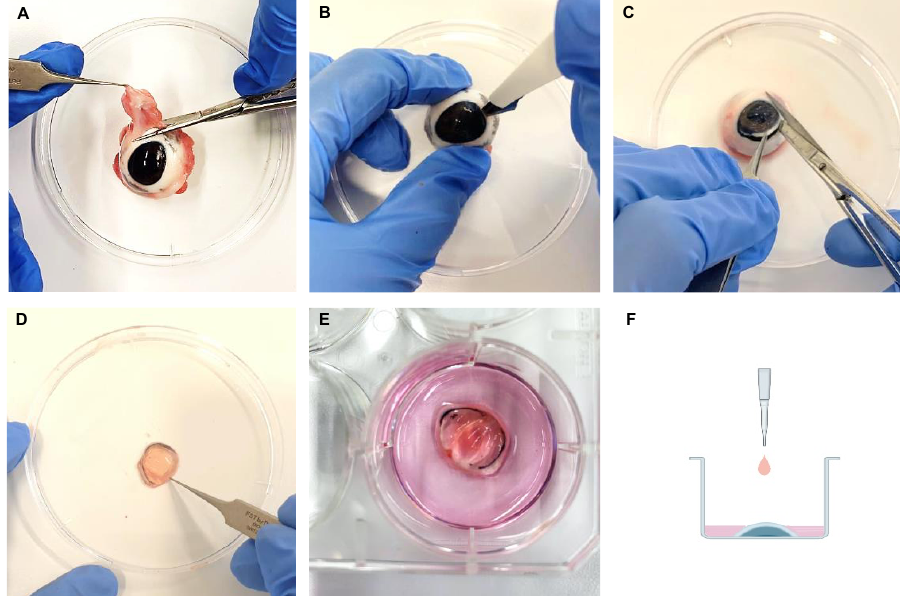
Figure 8. Porcine corneal extraction. ( A ) Muscles and tissues around the eye were removed. ( B – D ) To extract the cornea a cut was made around it with a scalpel and finalized with scissors. ( E ) A thin part of the sclera was left around the cornea. ( F ) The corneas were incubated in a 6-well plate, facing upwards, and the appropriate media was added. ( F ) Schematic figure depicts air-lifting technique, porcine cornea in a 6 well-plate facing upwards and culture media in pink meets the corneal epithelium surface.